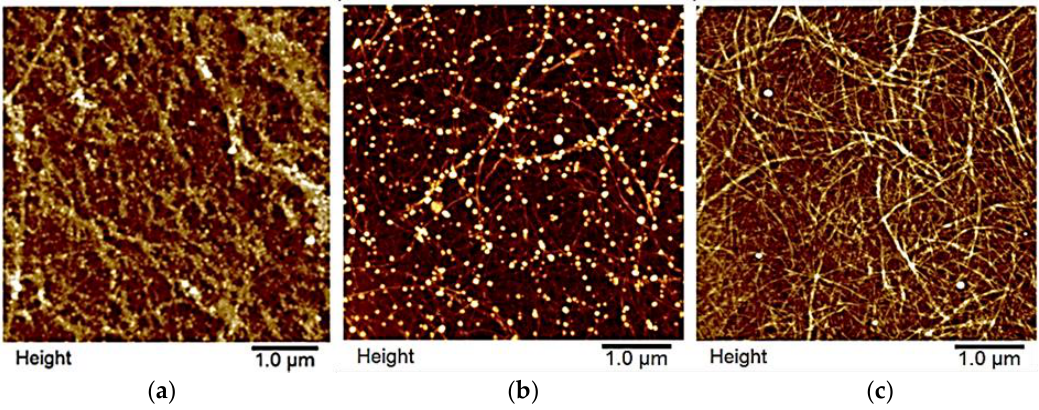
Figure 9. CNF surfaces coated with CLPs: ( a ) Tiny CLPs; ( b ) PL and PGA coated CLPs; and ( c ) reference.